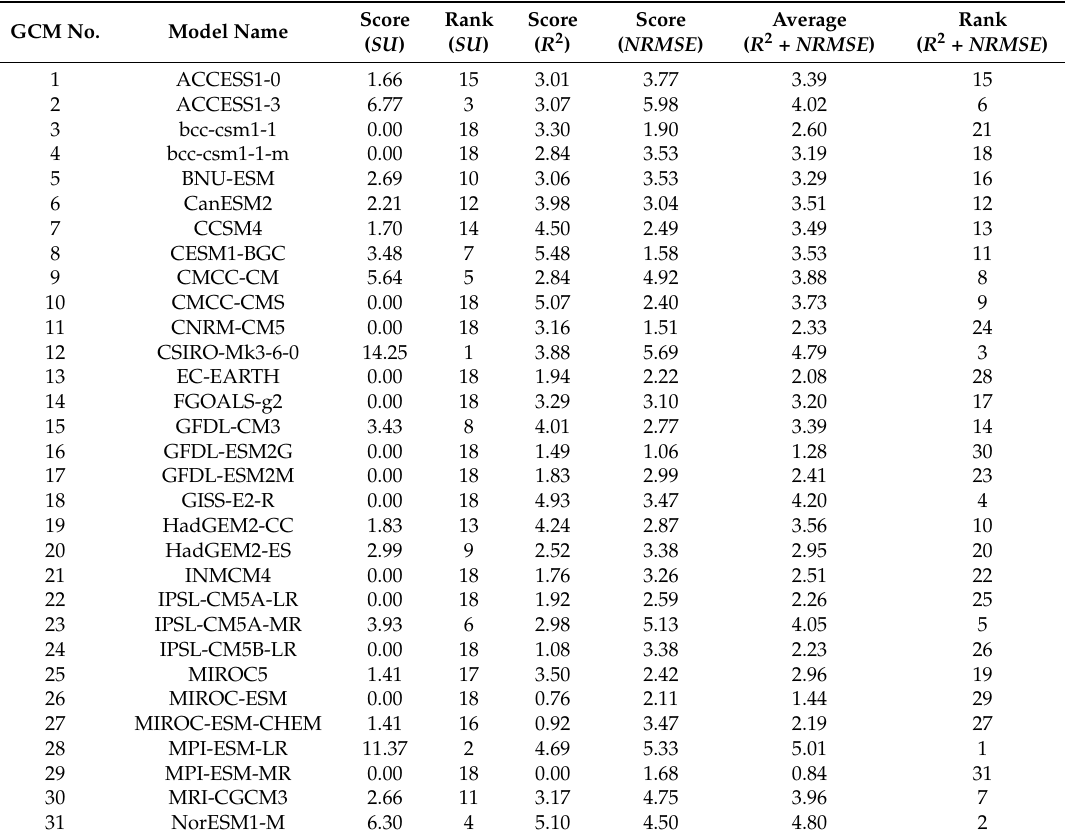
Table 3. The scores obtained from different GCMs according to their performance estimated using symmetric uncertainty and conventional